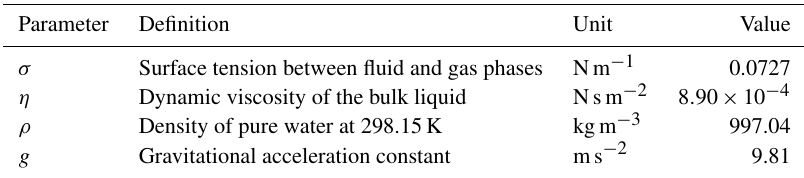
Table 1. Physical constants at 20 ◦ C used in this study.